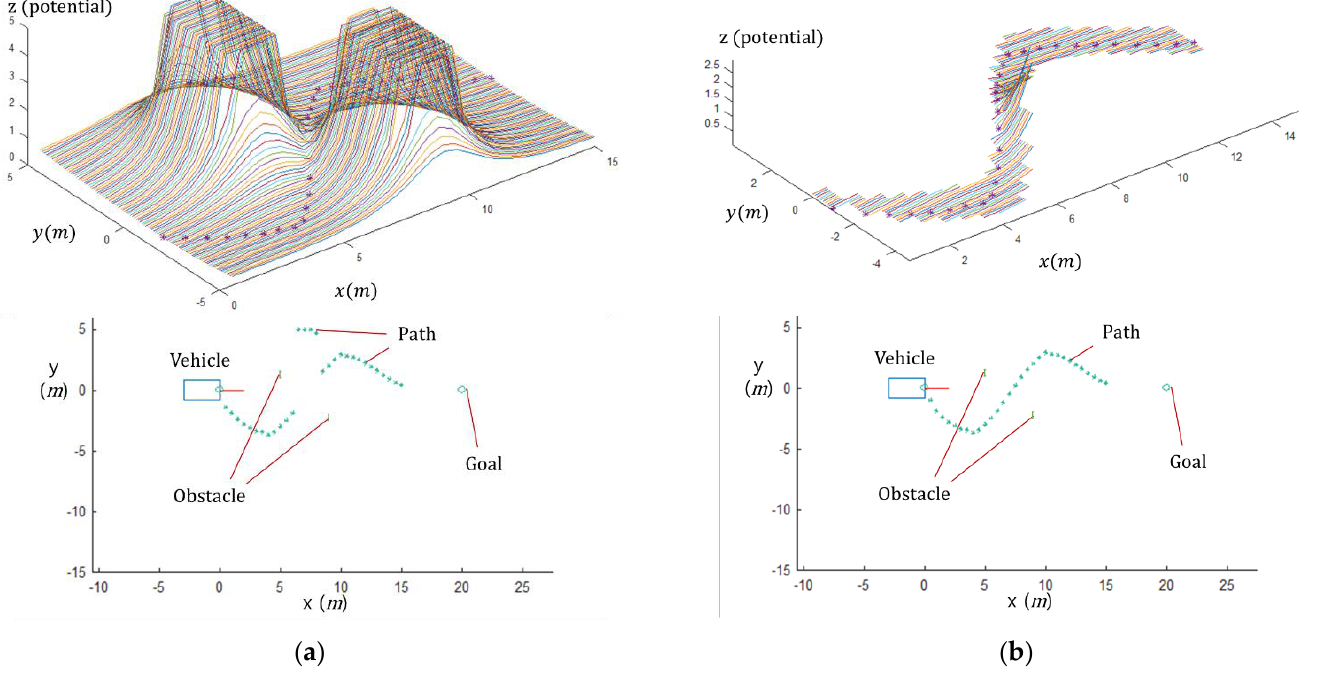
Figure 8. Potential field simulation: ( a ) simulation result of potential field algorithm with two obstacles; ( b ) simulation result of modified potential field algorithm with two obstacles.